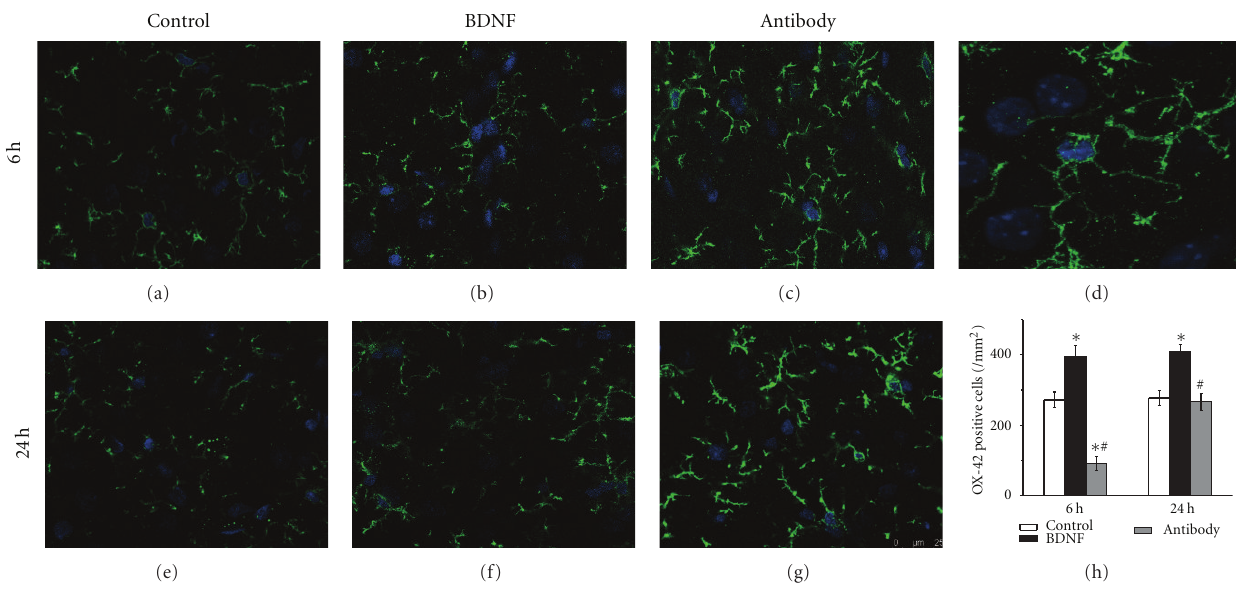
Figure 3: BDNF increasing the number of activated microglia after stroke Activated microglia in brain was marked by OX-42 and detected by confocal microscope following immunofluorescence. (a–c) 6h after reperfusion and (e–g) 24h after reperfusion; (a, e) control group, (b, f) BDNF group and (c, g) antibody group. (h) The number of phagocytotic microglia in BDNF group was significantly increased than control group 6 h and 24 h after reperfusion. BDNF antibody significantly decreased the number of activated microglia 6 h after reperfusion. Bars represent mean ± SD ( n = 6). ∗ P < . 05 versus control group, # P < . 05 versus BDNF group. Scale bars: 25 μ m.